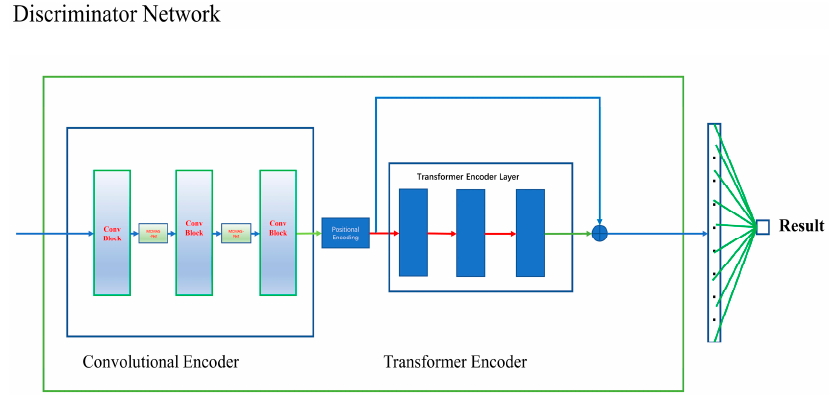
Figure 6. The Network Structure of the Discriminator.